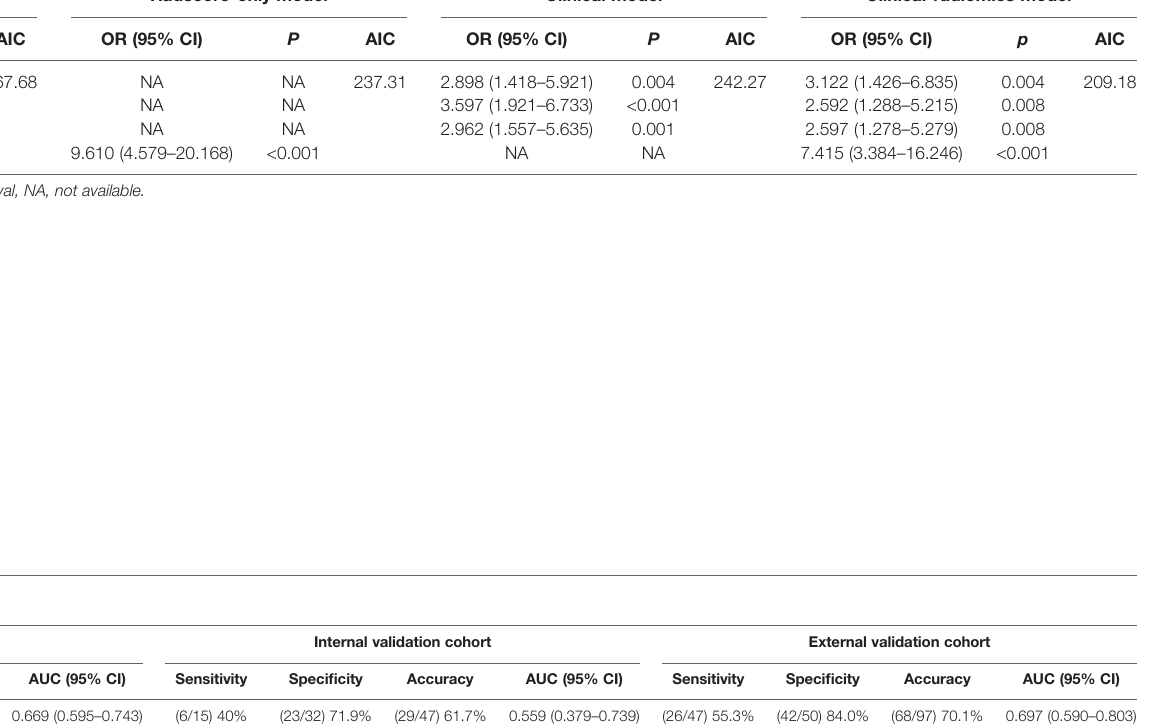
TABLE 3 | Comparison of four models by multivariate logistic regression analysis.